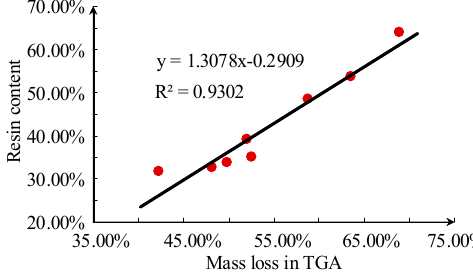
y = 1.3078x-0.2909